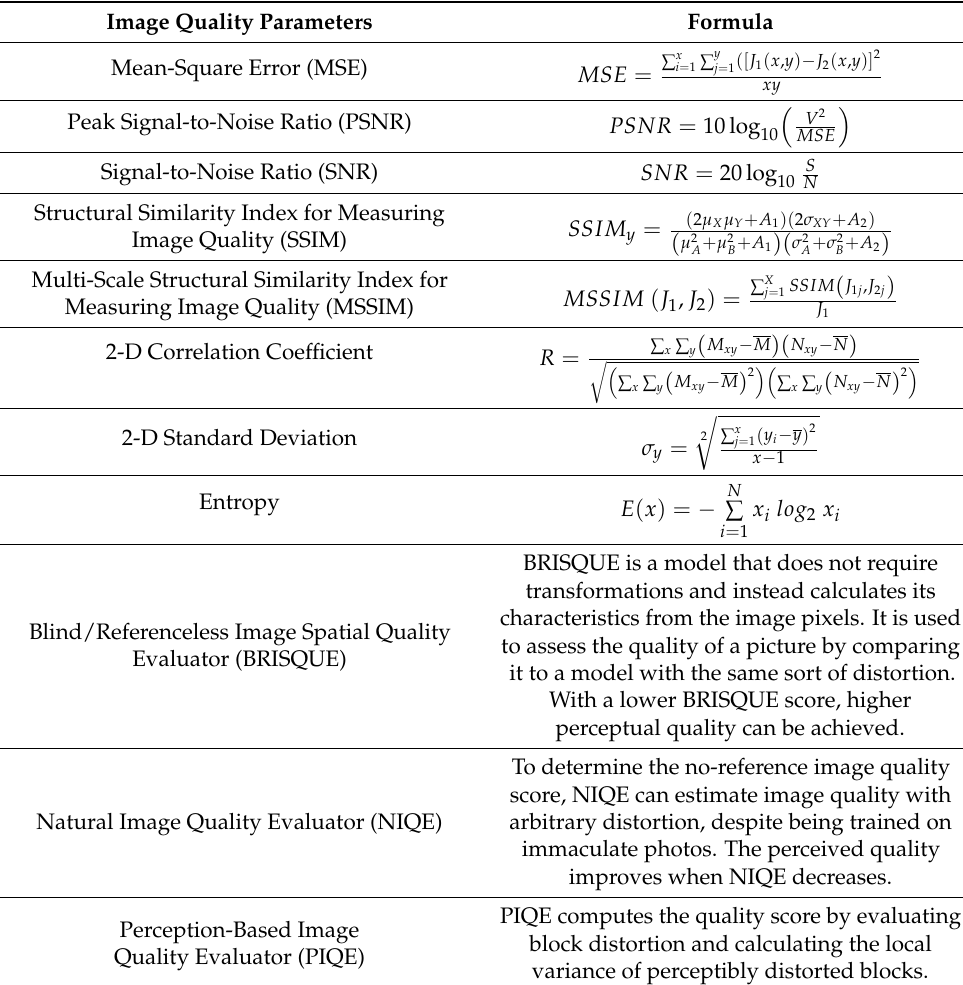
Table 1. IQP features extracted from